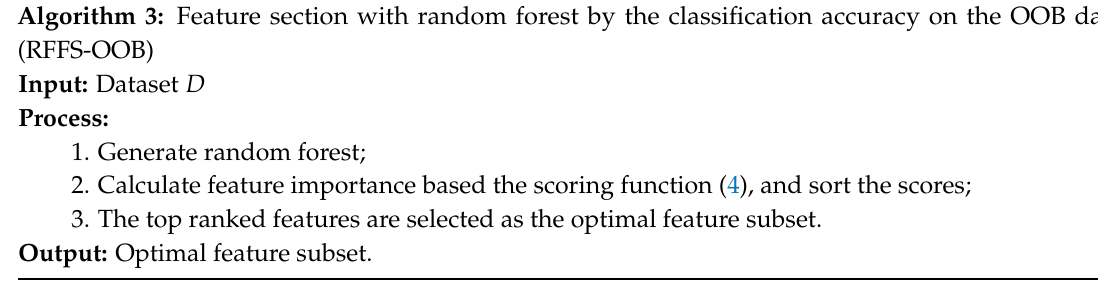
Algorithm 3: Feature section with random forest by the classification accuracy on the OOB data